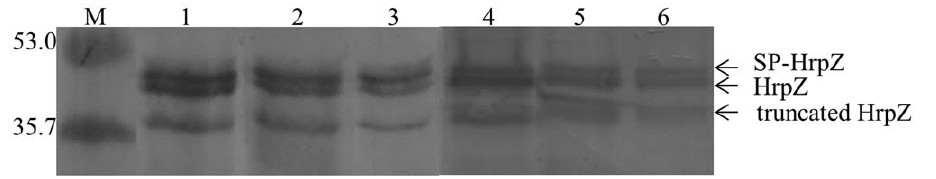
Figure 3. Western blot analysis of SP/HrpZ Psph in protein extracts from leaves of double and single transgenic N.benthamiana plants. Lane M: Marker in kDa (Broad range pre-stained SDS marker, Biorad). Lanes 1, 2, 3: Representative T2 double transgenic plants transformed with the plasmids pBin.Hyg.Tx-SP /hrpZ Psph and GW-IR3 showing high, moderate and low resistance levels, respectively. Lanes 4, 5, 6: Representative T2 plants transformed with the plasmid pBin.Hyg.Tx-SP /hrpZ Psph showing high, moderate and low resistance levels, respectively. The lower band represents the truncated form of the harpin (approx. 2 kDa smaller than the full-length HrpZ Psph ). Equal amounts of total protein (30 ug) were loaded.